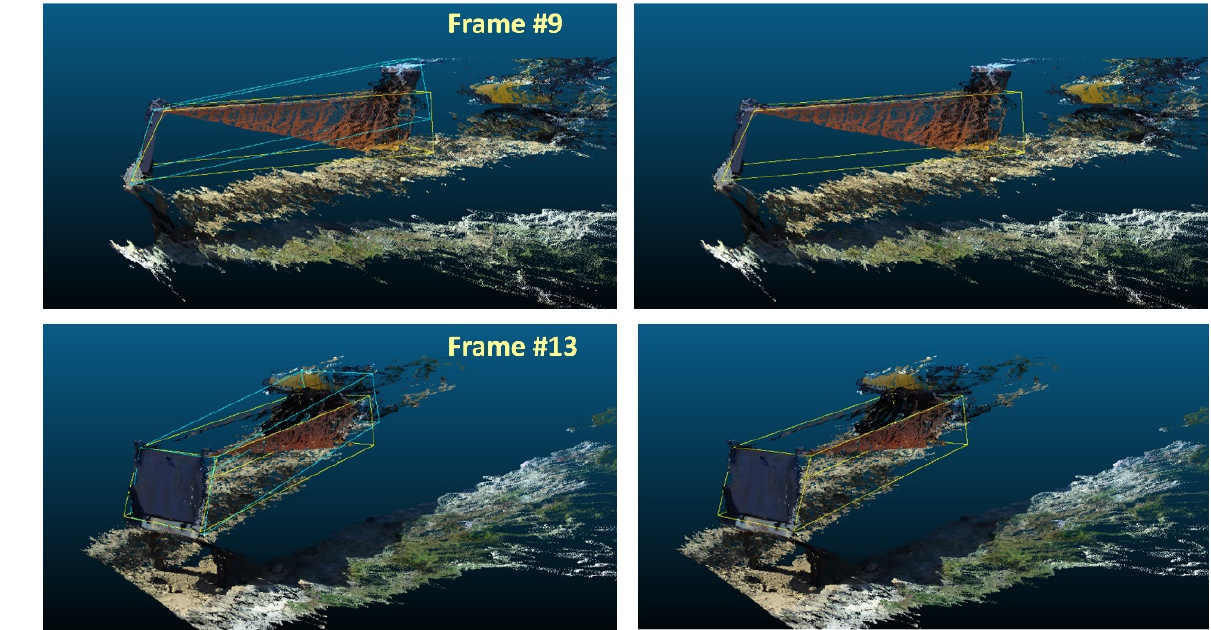
Figure 21. The result of precisely finding the three-dimensional position of the truck cargo box using the proposed method. Blue is the initial 3D position of the cargo box, and yellow is the result of a more precise 3D position. The side corners of the cargo box are more precisely matched.